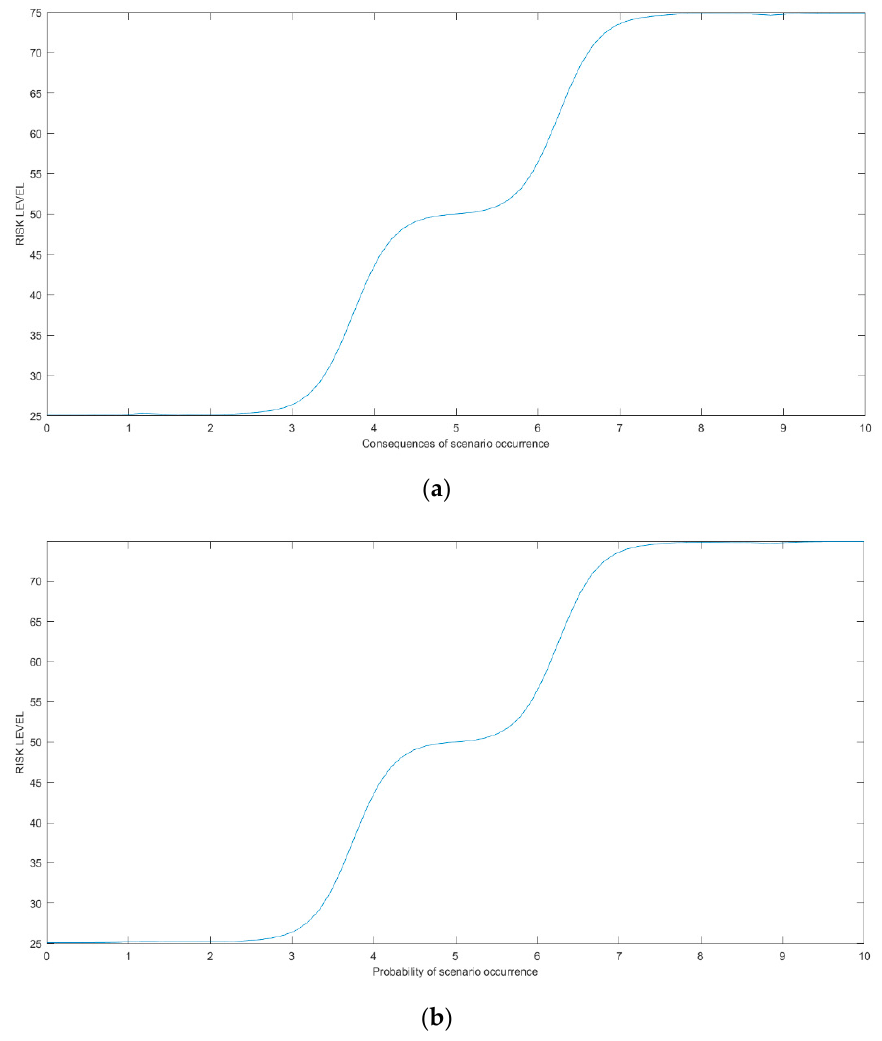
Figure 12. Influence of the course of input functions on the obtained risk index value: ( a ) the consequence function of the scenario; ( b ) the probability function of the scenario.